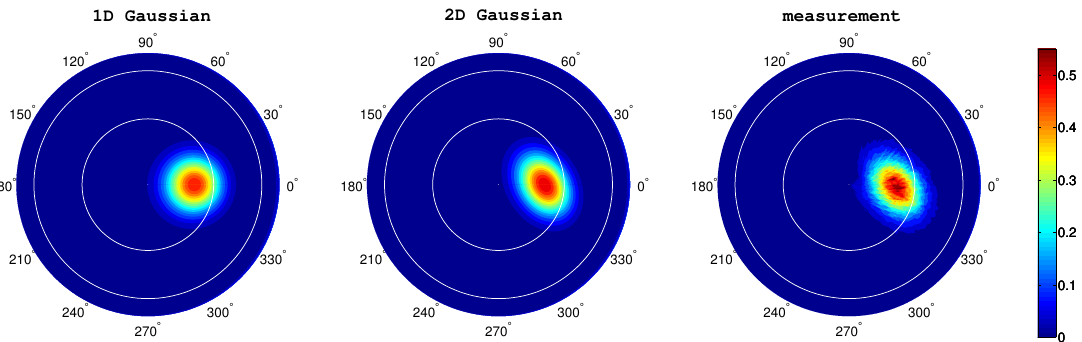
Figure 4. Comparison between model-simulated reflectances assuming a 1D Gaussian BRDF ( left ), a 2D Gaussian BRDF ( middle ), and measurements ( right ) obtained on 10 July